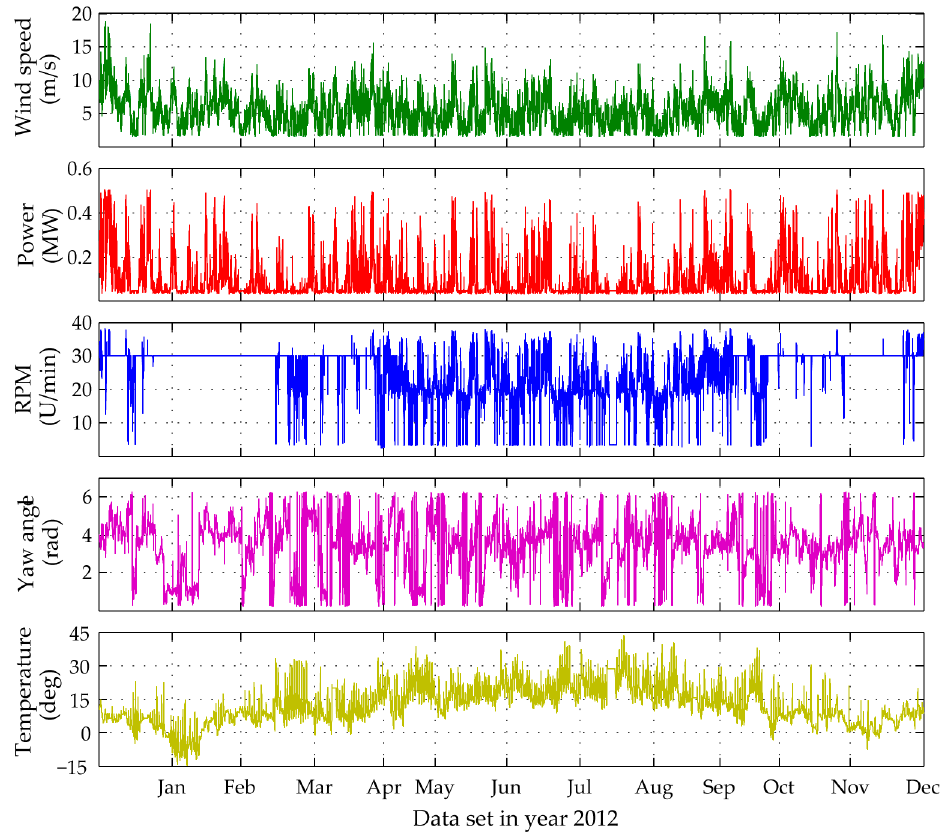
Figure 18. Time history plots of the selected PCE input variables for 49,956 datasets corresponding to complete year 2012.